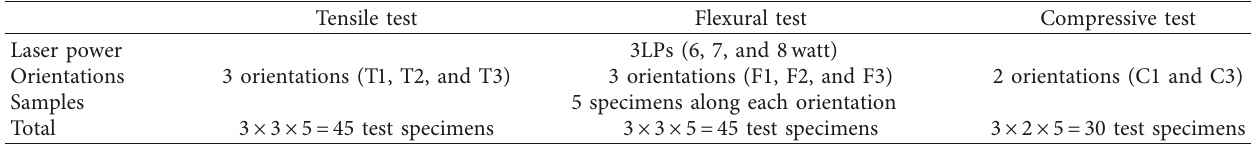
Figure 1: Geometry of tensile, compressive, and flexural test specimens. Table 4: Number and distribution of test specimens.